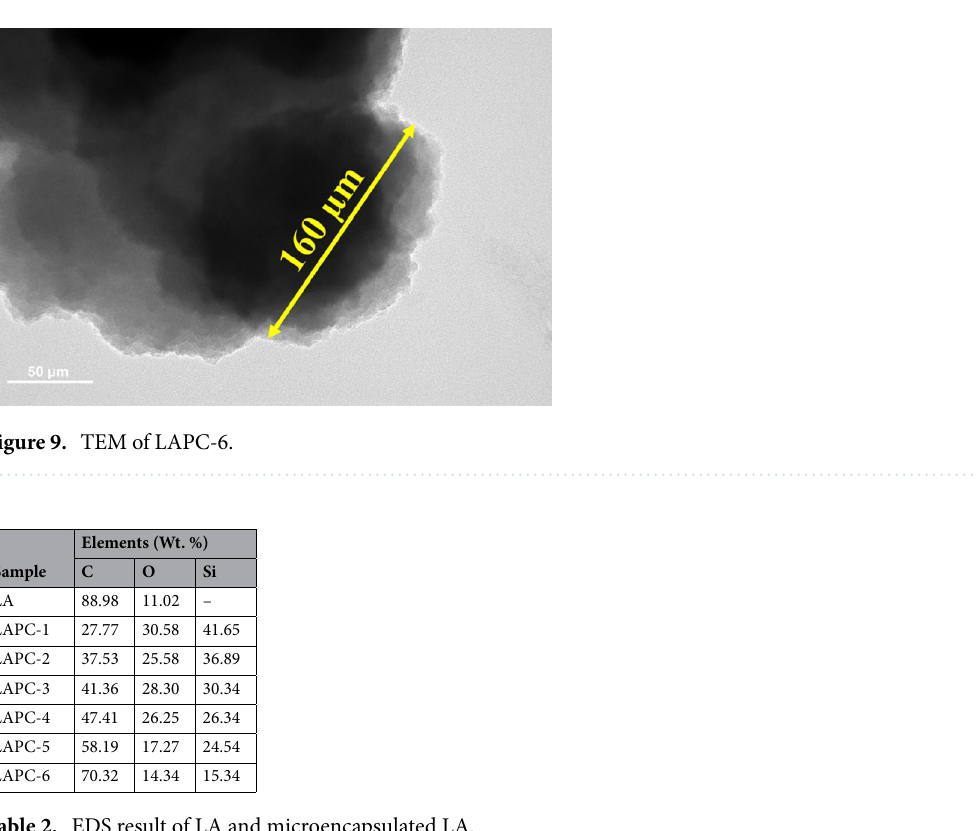
Table 2. EDS result of LA and microencapsulated LA.